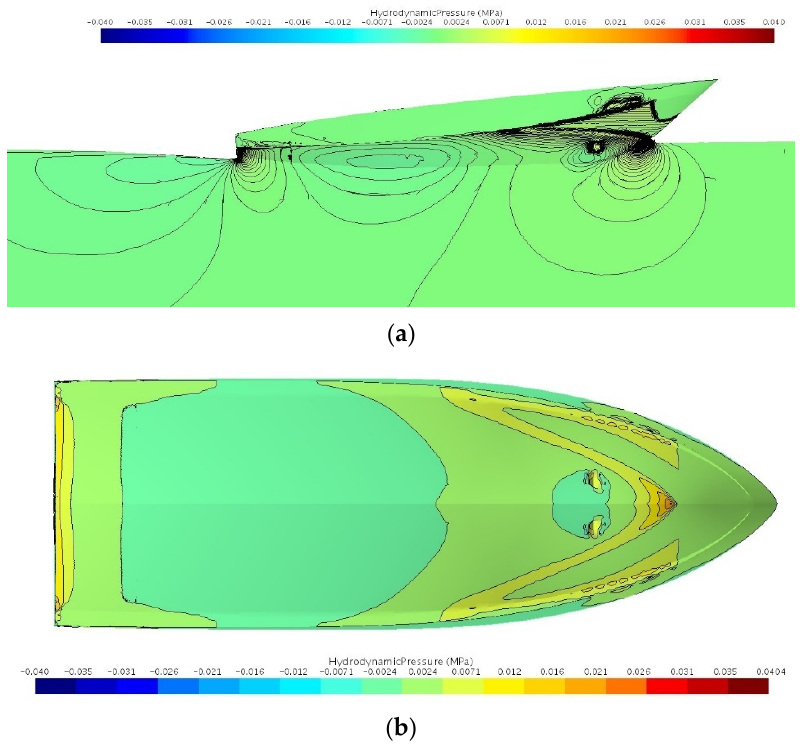
Figure 11. ( a ) Dynamic pressure field around the hull with interceptors, longitudinal view. ( b ) Dynamic pressure field around the hull with interceptors, bottom view.